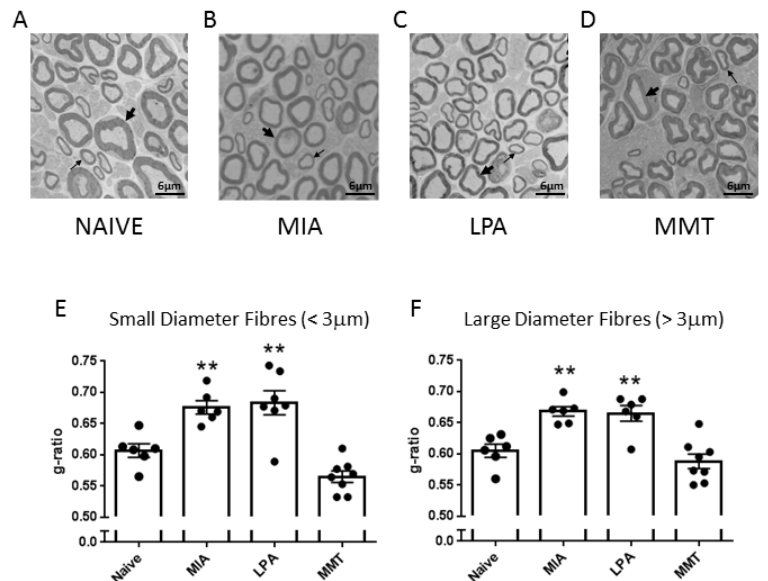
Figure 1. Myelination of Saphenous Nerve Fibres. Representative cross-sectional electron micro- graphs of ipsilateral saphenous nerves harvested from ( A ) naïve, ( B ) MIA, ( C ) LPA, and ( D ) MMT rats. Myelin thickness (g-ratio analysis) was significantly reduced in MIA- and LPA-treated joints in both small diameter ( E ) and large diameter ( F ) neurones. Myelin thickness was not affected by MMT surgery at the 28 day timepoint. Thick arrows signify large diameter axons; thin arrows refer to small diameter axons. ** p < 0.01 compared to naive, one-way ANOVA with Dunnett’s post-hoc test. Data are expressed as mean ± S.E.M ( n = 6–8 animals/group). Immunohistochemical examination of dorsal root ganglia, showed an increase in Na v 1.7 expression in the neurones innervating the ipsilateral knee joint of MIA and LPA rats ( p < 0.05, Figure 2E). The MMT surgery model did not induce a significant change in Na v 1.7 expression ( p = 0.6, Figure 2E).